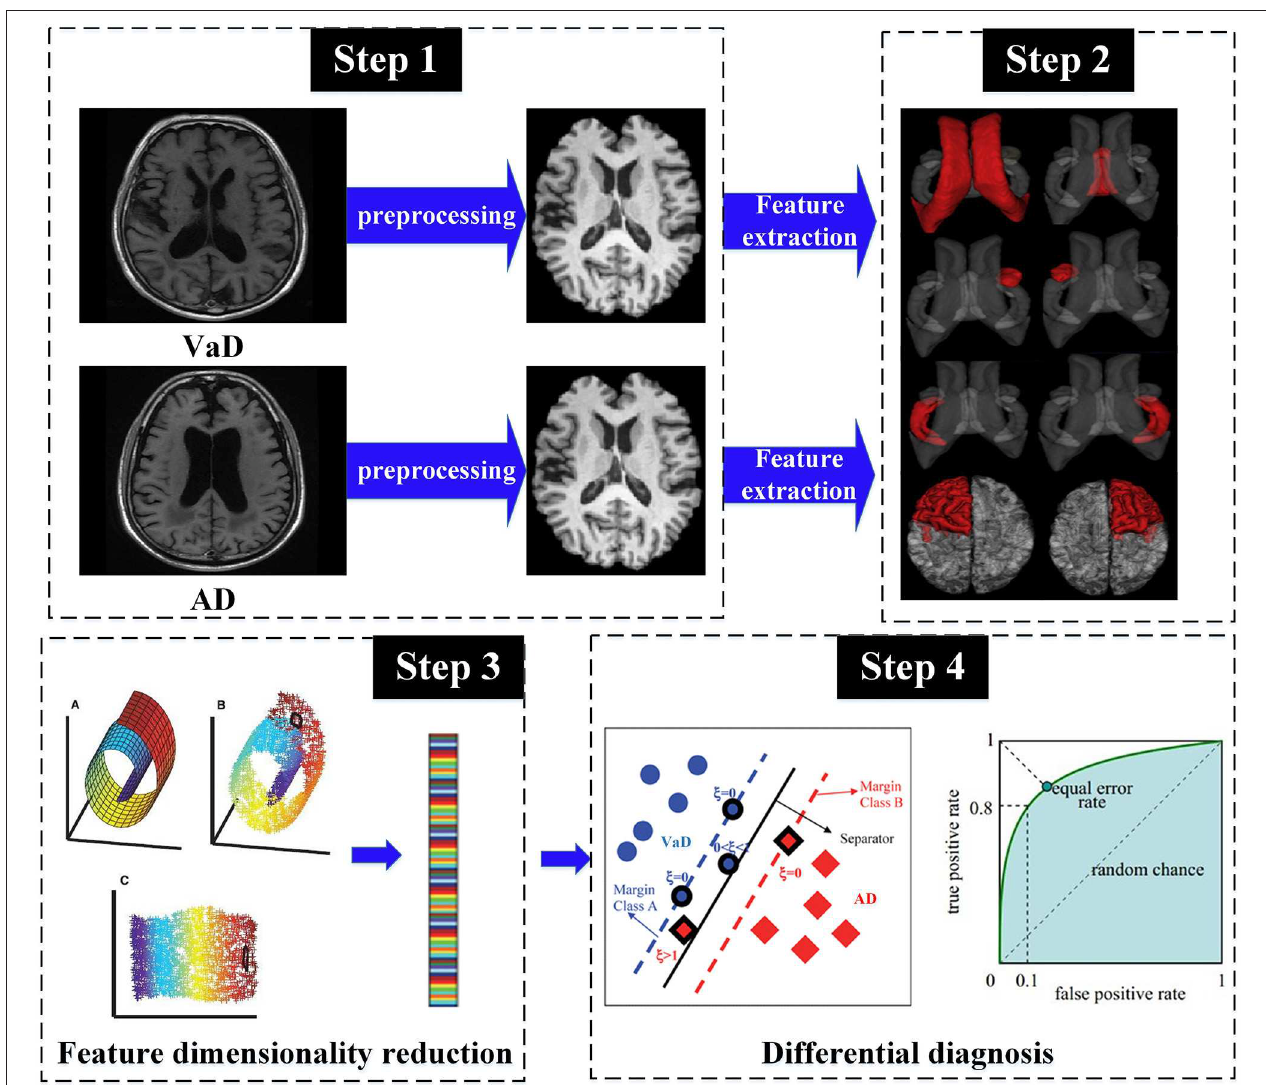
FIGURE 1 | The pipeline of proposed framework for the distinction of VaD vs.